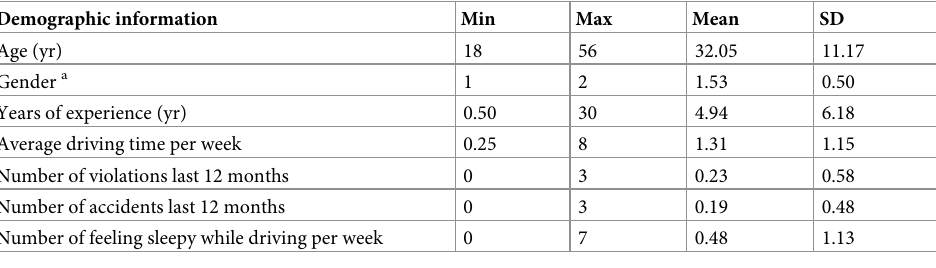
Table 1. Demographic information of